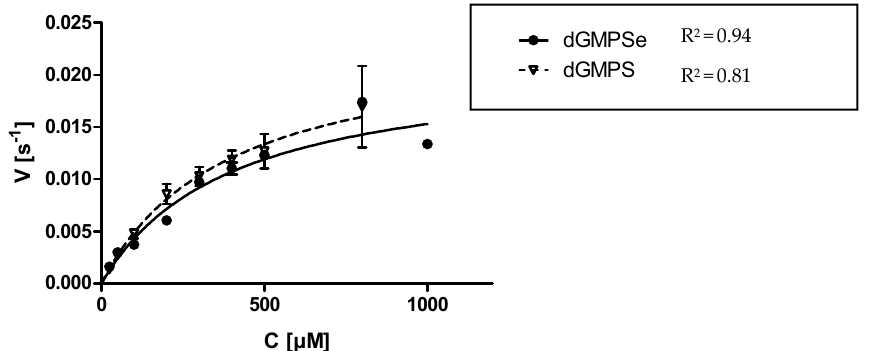
Figure 3. The profile of the nonlinear regression Michaelis–Menten fit of the HINT1-assisted hy- drolysis of dGMPSe and dGMPS. Reactions were performed at different substrate concentrations in triplicate. Error bars represent ± SEM. Table 2. Kinetic characterization of HINT1 substrates.